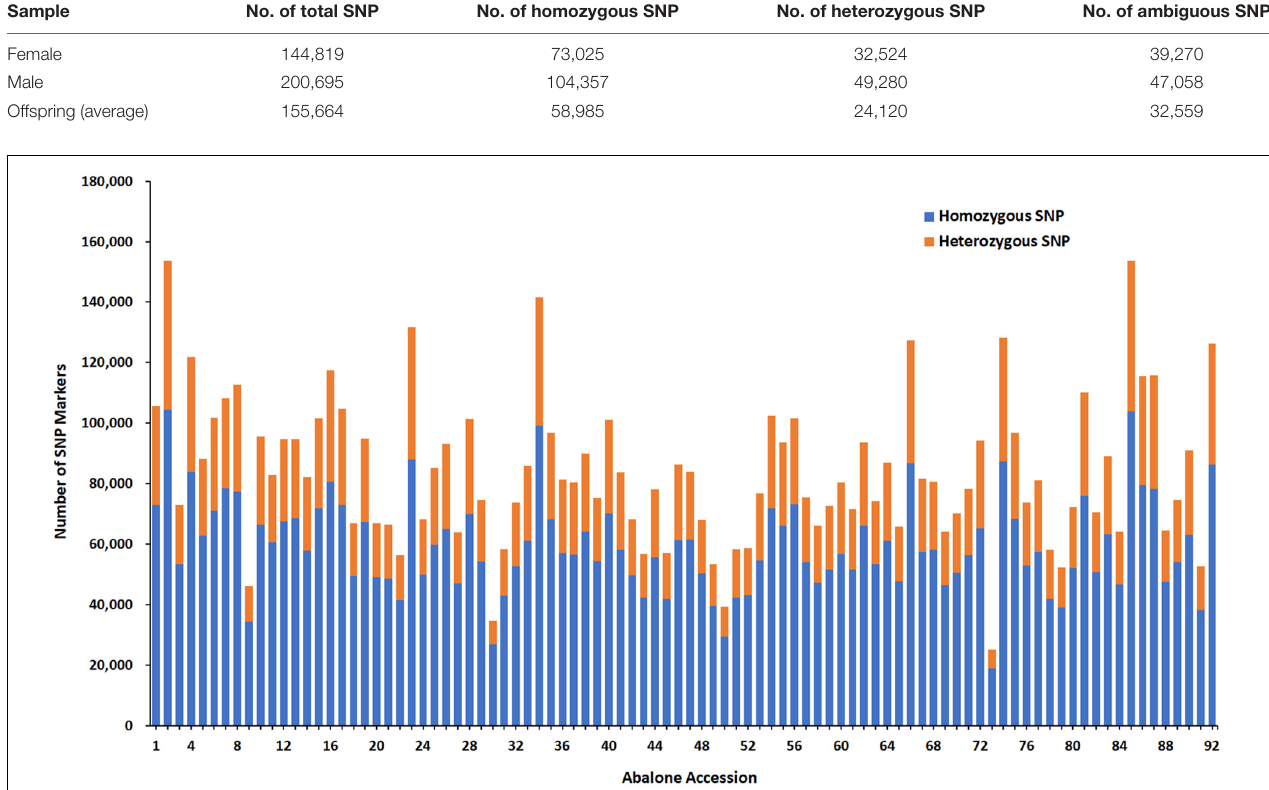
FIGURE 1 | Number of SNP markers for all samples. The x-axis indicates abalone accession including parents and 90 progenies and the y-axis indicates the number of SNP markers.